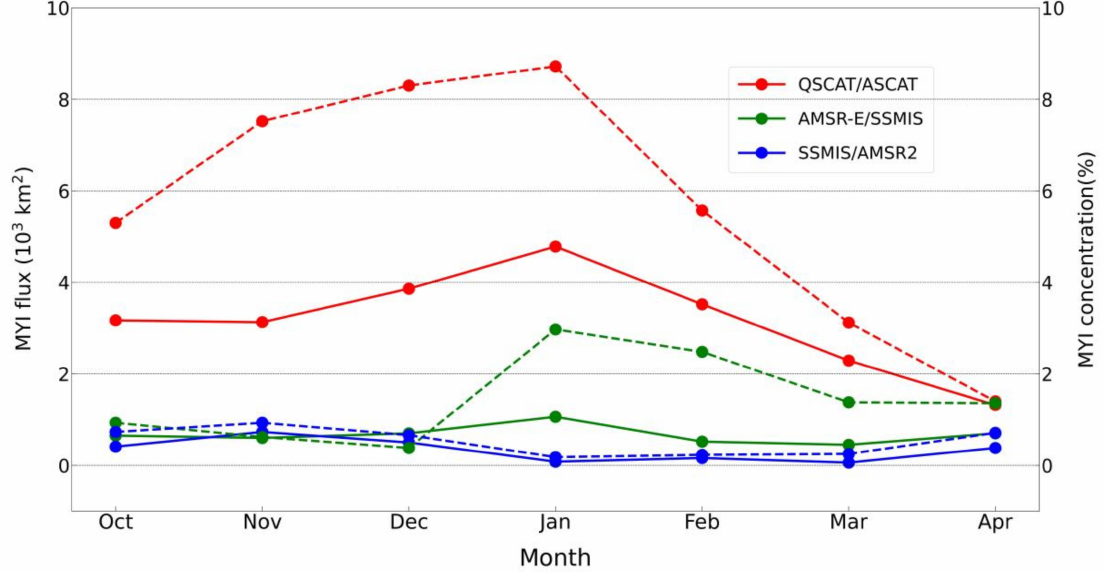
Figure 13. Monthly mean differences in MYI areal flux (solid lines) and MYI concentration (dash lines) through all gates caused by different data sources. QSCAT/ASCAT represents the deviation between the two scatterometers, and so